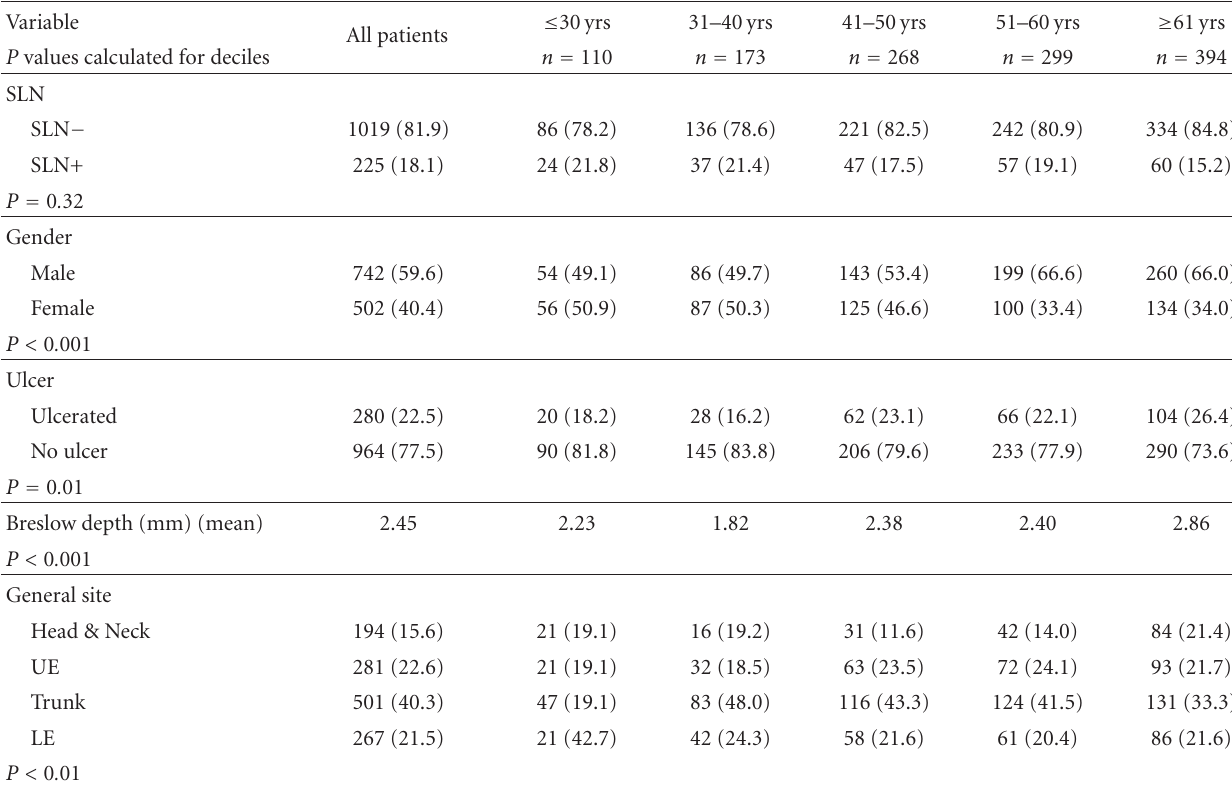
Table 1: Patient clinicopathologic variables, based on decade of life.